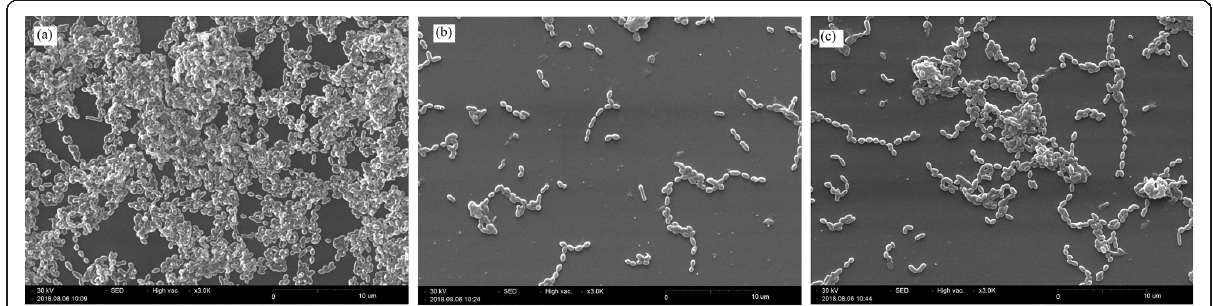
Fig. 3 The scanning electron micrograph of Streptococcus mutans (ATCC 35668) biofilm formed after 24 h of incubation. a Control and in the presence of sub- MIC levels of b AEEP (6 μ g/ml), c Q (20 μ g/ml)